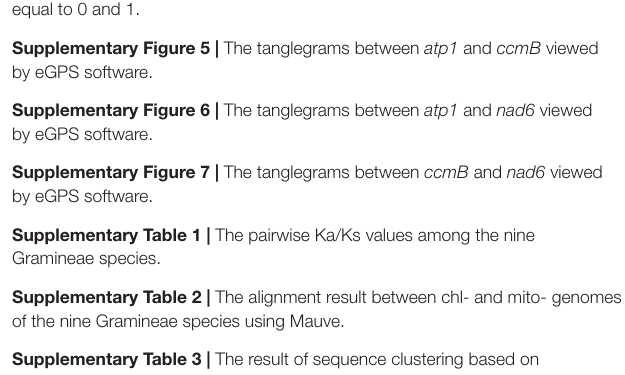
Supplementary Figure 1 | The visualization of coverage depth in mitogenome of Elymus sibiricus . The coverage depth was showed with the color of dark blue. Supplementary Figure 2 | Synteny between mitochondrial and chloroplast genomes in Gramineae was analyzed using Mauve software. Supplementary Figure 3 | RNA editing sites prediction of the 10 shared genes in Gramineae mitogenomes. A to J indicated RNA editing sites of atp1 , ccmB , ccmC , ccmFN , cox1 , cox2 , matR , nad6 , nad7, and nad9 . All the figures possessed the same order of species with A. Supplementary Figure 4 | Heatmap showing the correction coefficients among the 88 mitogenomes (A) and the proportion of SSR sequences to the whole mitogenome (B) . The species order from top to bottom in (A) and from left to right in (B) is consistent with Figure 7 . The species in a red box belongs to an Order. The white color and blue color presented relationship coefficients were equal to 0 and 1. Supplementary Figure 5 | The tanglegrams between atp1 and ccmB viewed by eGPS software. Supplementary Figure 6 | The tanglegrams between atp1 and nad6 viewed by eGPS software. Supplementary Figure 7 | The tanglegrams between ccmB and nad6 viewed by eGPS software. Supplementary Table 1 | The pairwise Ka/Ks values among the nine Gramineae species. Supplementary Table 2 | The alignment result between chl- and mito- genomes of the nine Gramineae species using Mauve. Supplementary Table 3 | The result of sequence clustering based on